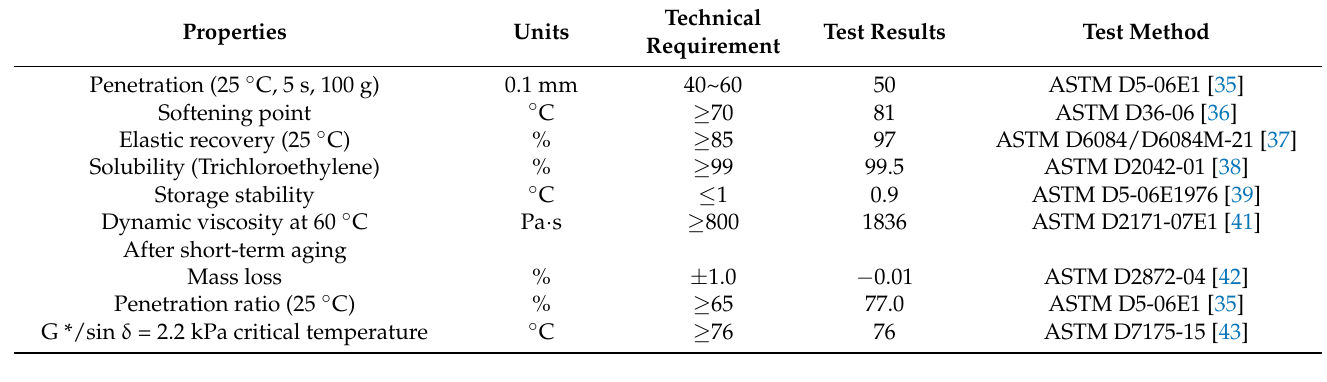
Table 7. Technical index of the SBS modified bitumen (PG76-22).